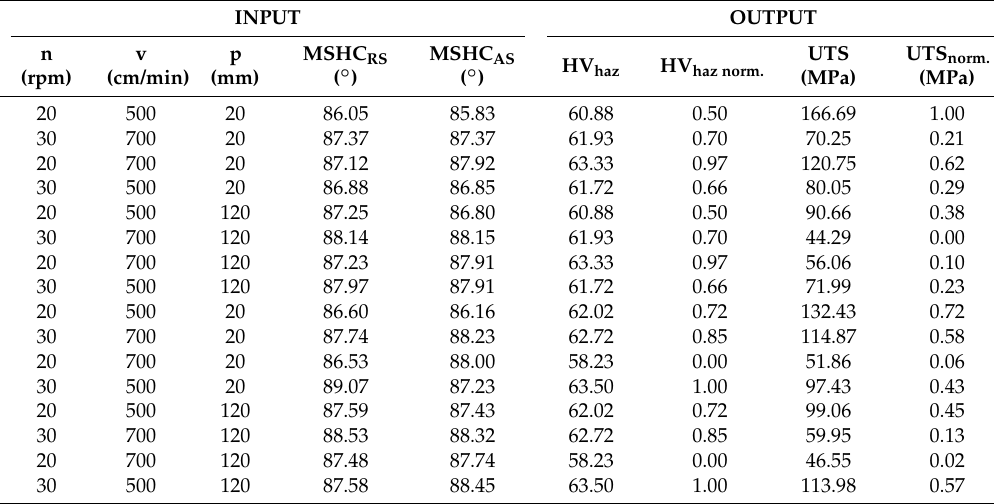
Table 3. Measured data used to train the